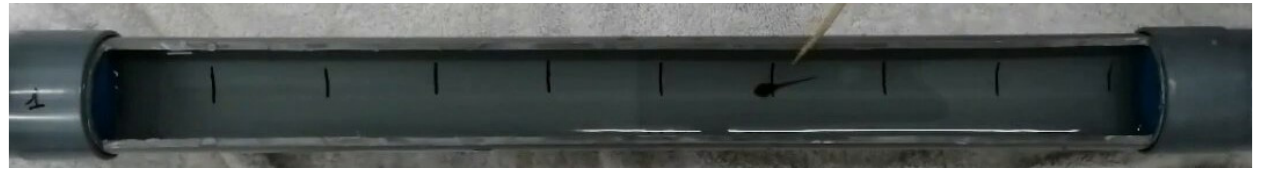
Figure 2. Swim channel with 5 cm gradations.